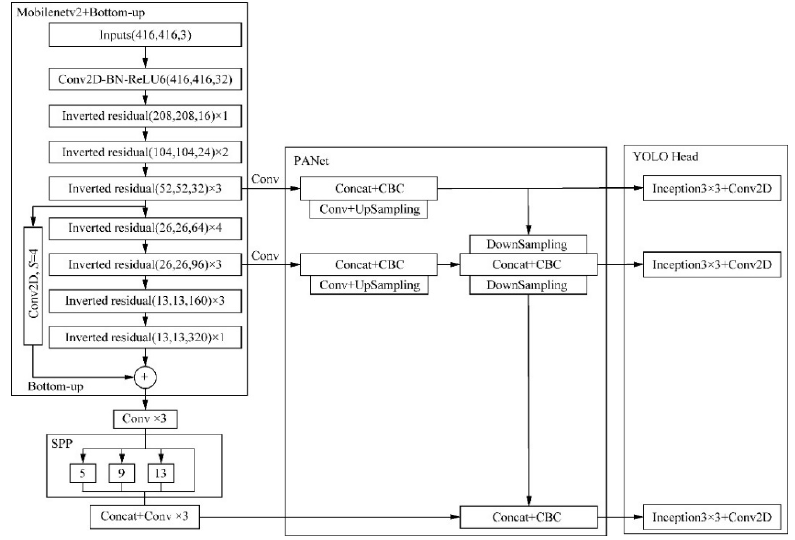
Figure 10. Inception 3 × 3 structure figure.